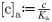
Phase portraits for different extracellular xanthosine concentrations.All parameters but [c]a are as presented in Table 1. The extracellular xanthosine concentration in these plots is [c]a = 7 in (A) and [c]a = 40 in (B) (recall that [c]a≔cKa with Ka = 5 ⋅ 10−5M, so [c]a is dimensionless). Tuning [c]a moves the orange line (xanthosine nullcline), but the blue curve (mRNA nullcline) is unchanged (see also S1 Text). It can clearly be seen that in (A) there is only the lower fixed point (fixed point number 1), whereas in (B) there is only the upper one (fixed point number 3). In between lies the bistable case that was shown in Fig 5.